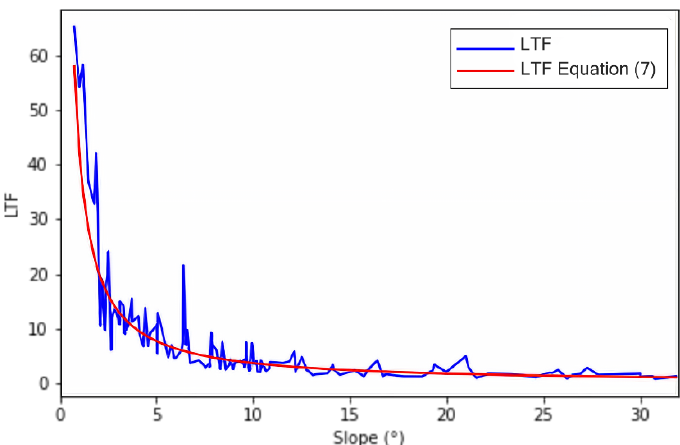
Figure 6. Calculated LTF threshold values ( blue ) fitted with Equation (7) ( red ) for the training dataset. Landslide Triggering Factor Error—False Positive Rate (FPR)